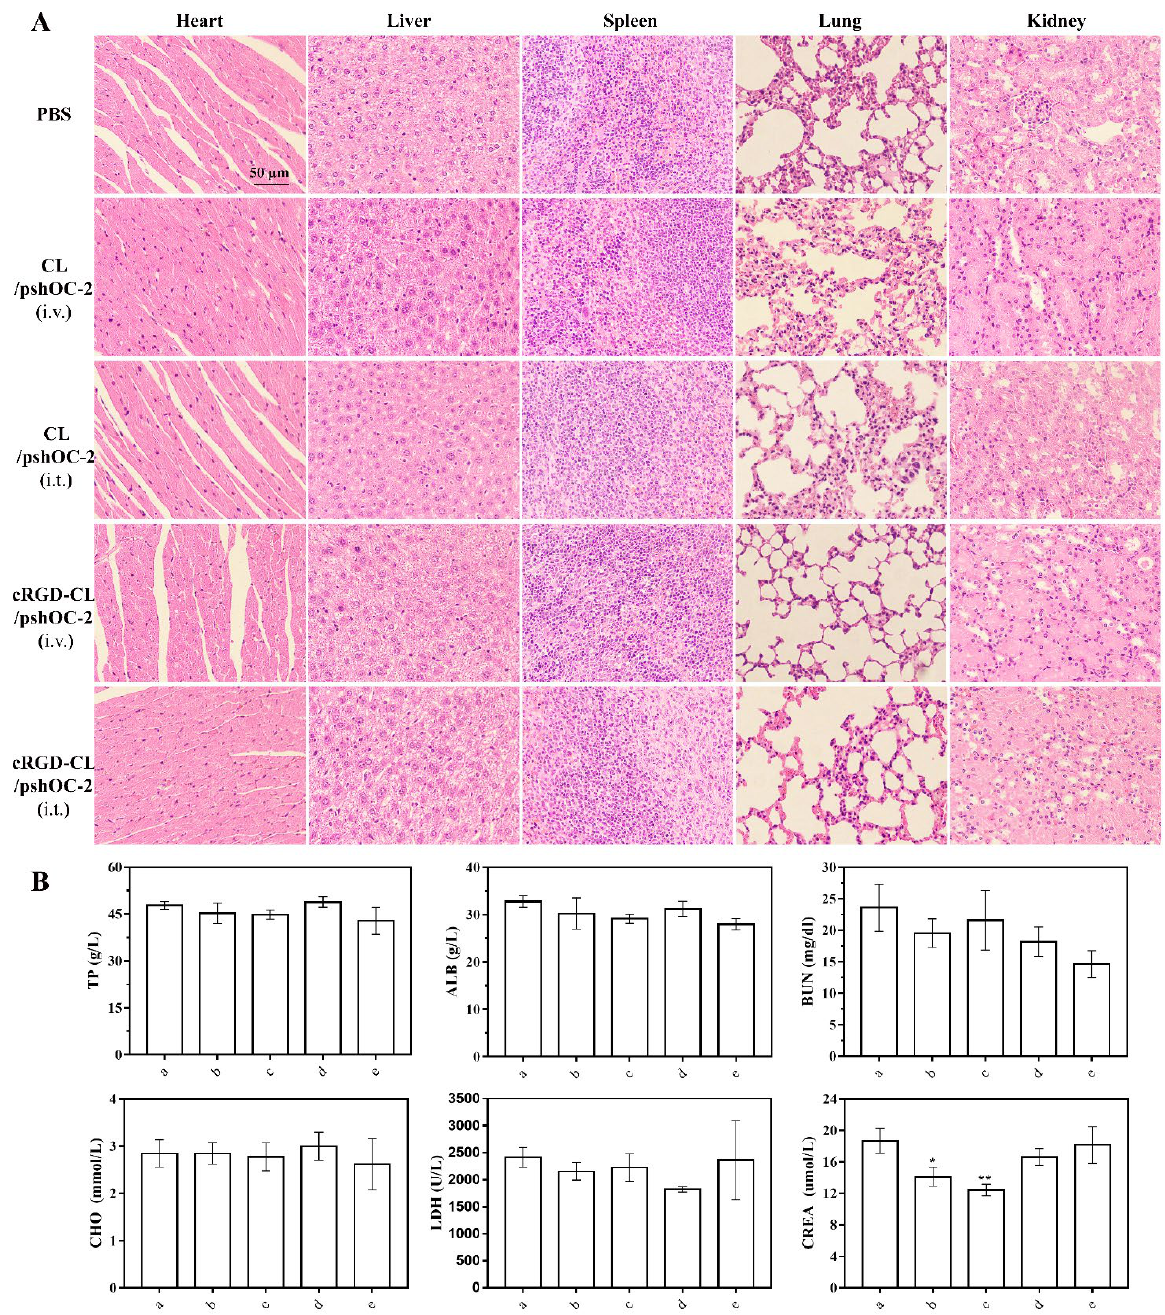
Figure 8. Analyzes of Organs Pathology and Serum Biochemistry. ( A ) H&E staining of major organs from each group. Scale bar: 50 μm. ( B ) Serum levels of blood markers. Liver function: albumin (ALB); Renal function: blood urea nitrogen (BUN) and creatinine (CREA); Blood lipid: cholesterol (CHO); Myocardium: lactate dehydrogenase (LDH); Others: total protein (TP). a: PBS, b: CL/pshOC-2 (i.v.), c: CL/pshOC-2 (i.t.), d: cRGD-CL/pshOC-2 (i.v.), e: cRGD-CL/pshOC-2 (i.t.). Data were presented as means ± SD, * p < 0.05, ** p < 0.01.